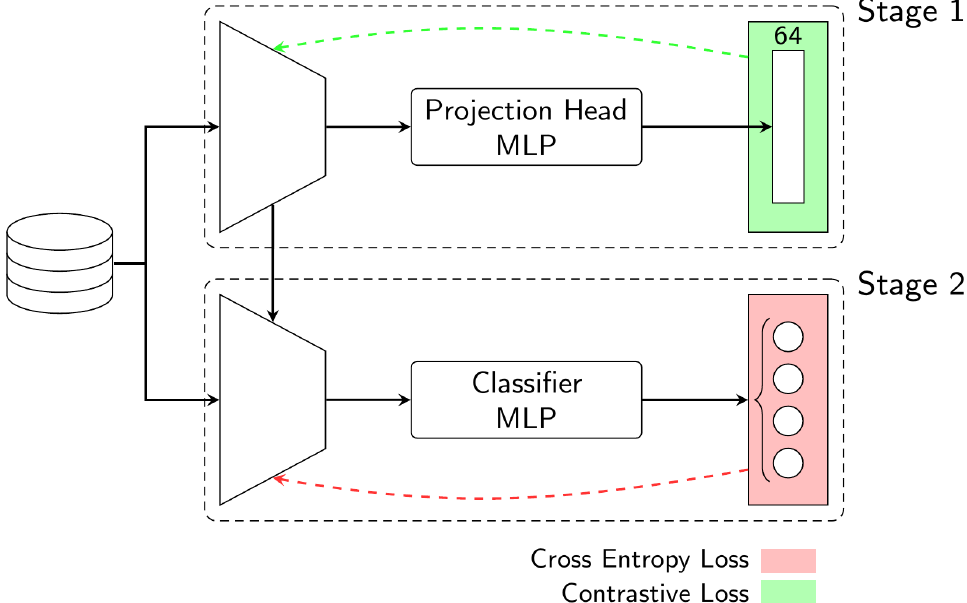
Figure 7. Model’s architecture in Multi-stage Multi-loss Training. In the first stage, it is used the contrastive loss and in the second stage it is used the cross-entropy